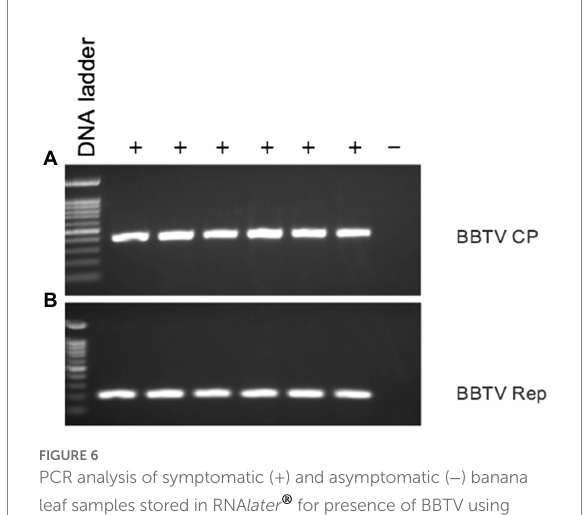
FIGURE 6 PCR analysis of symptomatic (+) and asymptomatic ( − ) banana leaf samples stored in RNA later ® for presence of BBTV using BBTV (A) CP gene-specific, and (B) Rep gene-specific